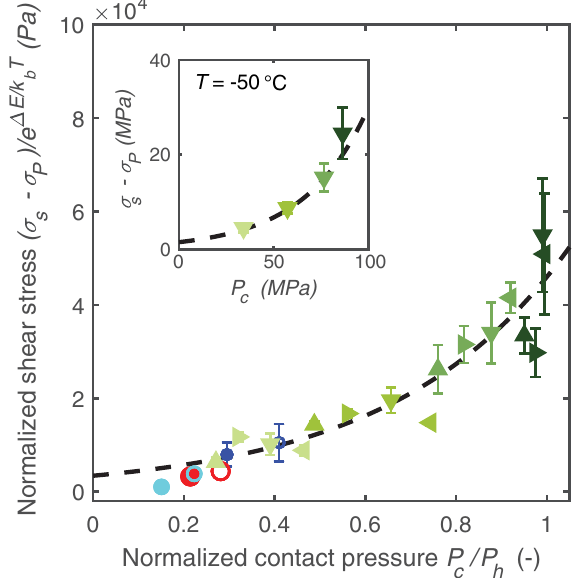
FIG. 11. Normalized effective shear stress ð σ s − σ P Þ =e Δ E=k B T as a function of the normalized contact pressure P c =P h for various sliders, surface roughnesses, and temperatures at a sliding speed of 0 . 38 mm = s. Here, the effective shear stress is based on the measured friction force, excluding the ploughing contribution. The plastic indentation of the sphere in the ice surface, mainly for high surface roughnesses, results in a ploughing area A P and ploughing force F P ¼ A P P h [Eq. (2)]. The ploughing can explain upto40%oftheobservedincreasedfriction.Thedashedlineisafit using Eq. (5). The same symbols and colors are used as in Fig. 4. Inset: effective shear stress σ s − σ P as a function of the contact pressure P c for various glass sliders with increasing surface roughness at T ¼ − 50 °C and a sliding speed of 0 . 38 mm =